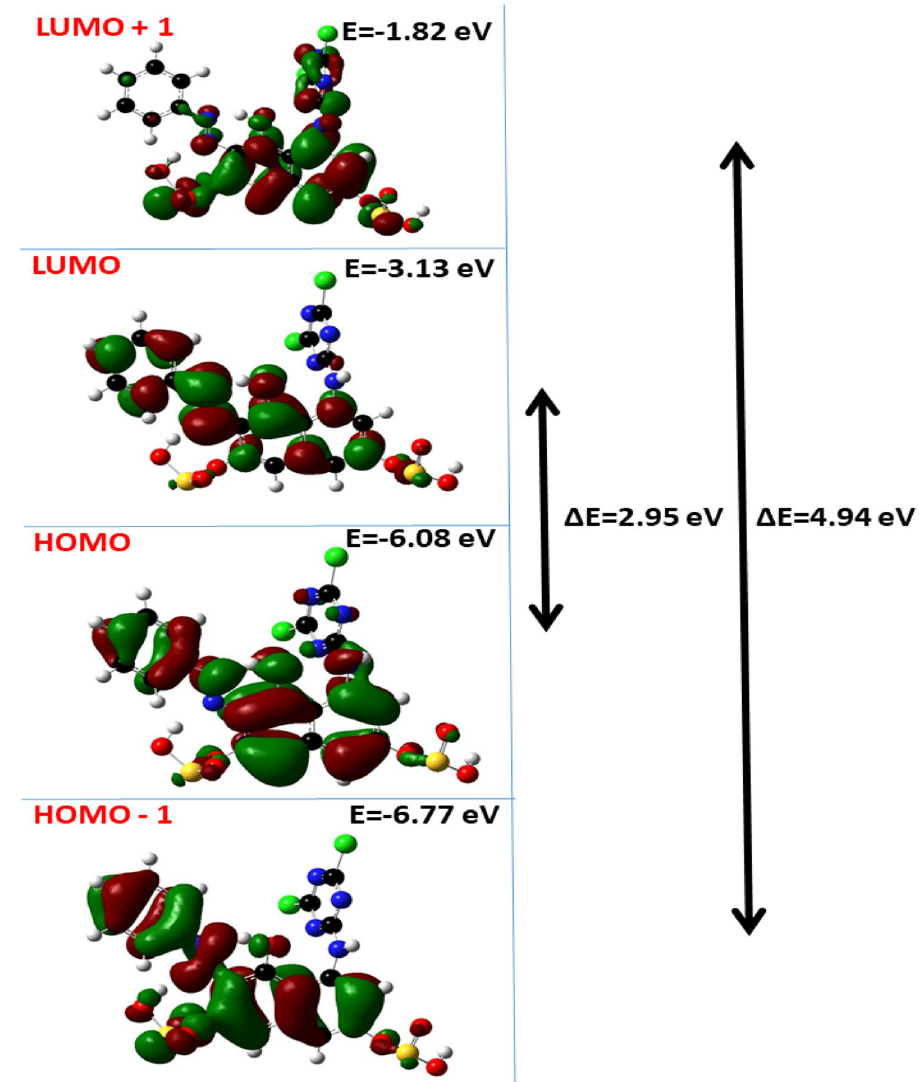
Fig. 4 HOMO -1, HOMO, LUMO and LUMO + 1 diagrams of cyanurated H-acid with aniline (CHA) using RB3LYP method with 6-31G (d,p) basis